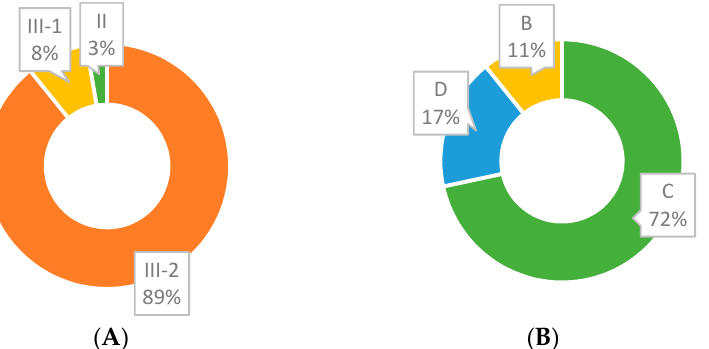
Figure 7. ( A ). III-2 accounts for the majority of ’Evidence for Outcome—Level (Quality) of evidence for diagnostic tests” (NHMRC Evidence Hierarchy). ( B ) C accounts for the majority of grades (Strength) of recommendation.